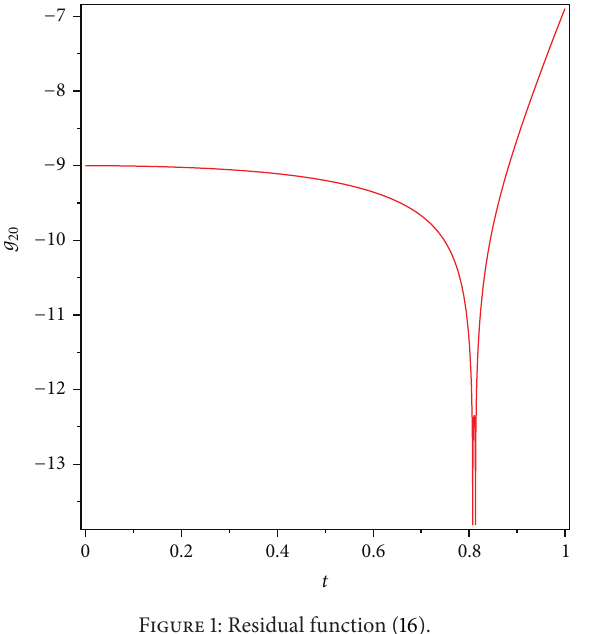
Figure 1: Residual function (16).